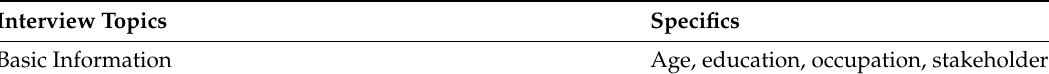
Table 1. Interview topics, outlines, and